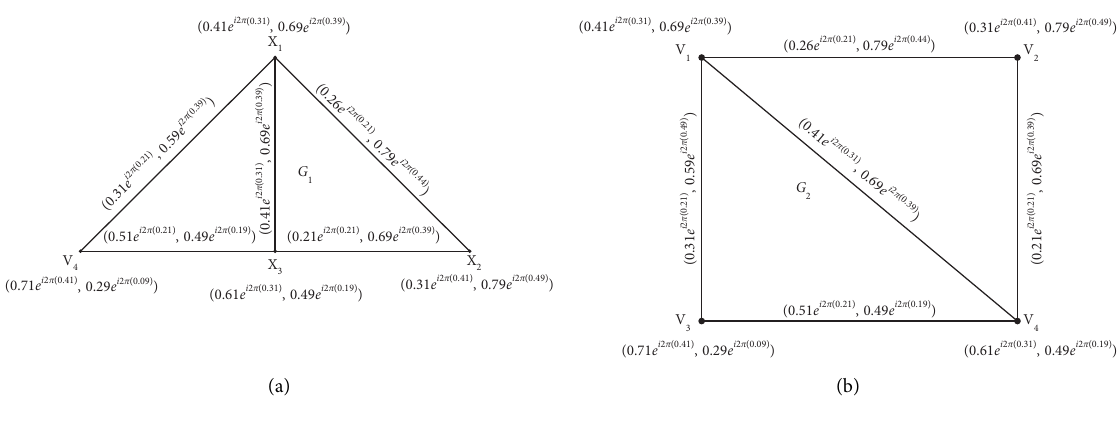
Figure 7: The two graphs shown are isomorphic.